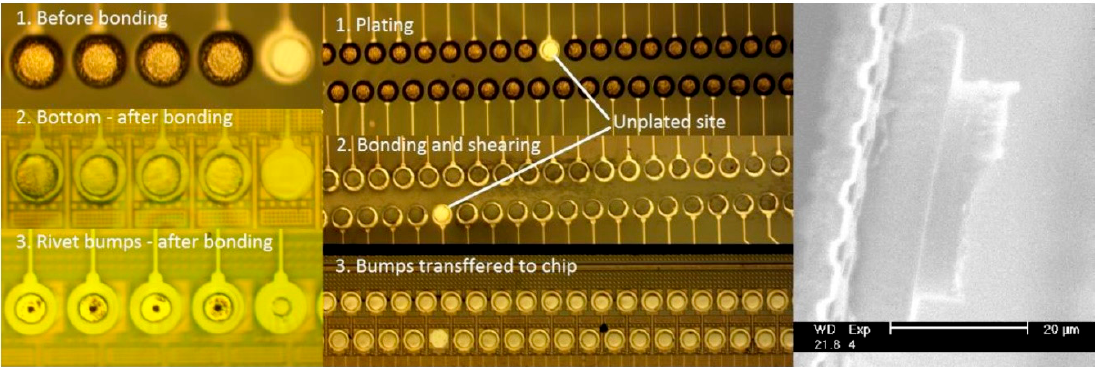
Figure 3. ( Left ) Au bumps pre- and post-bonding. ( Middle ) shear test. ( Right ) sheared bump close-